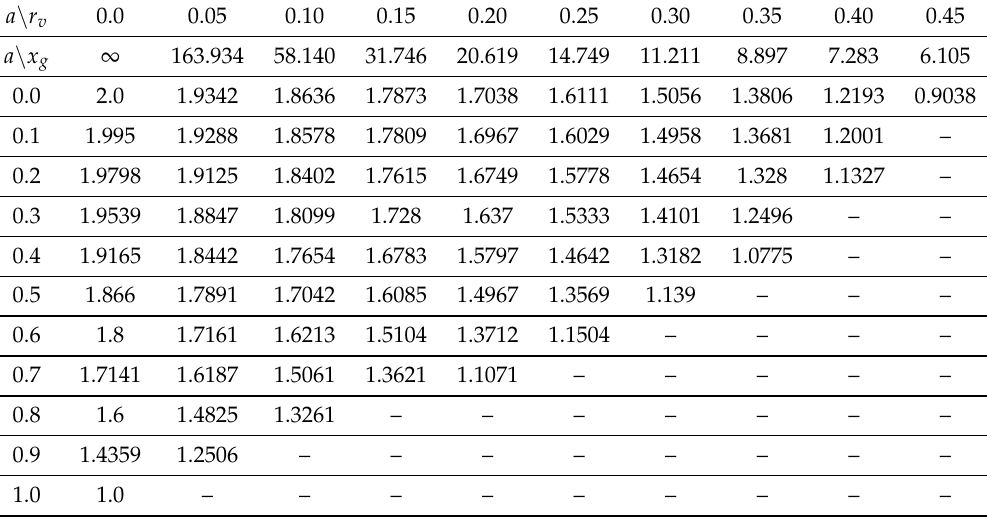
Table 2. The event horizons for different values of the parameters a , r v and x g